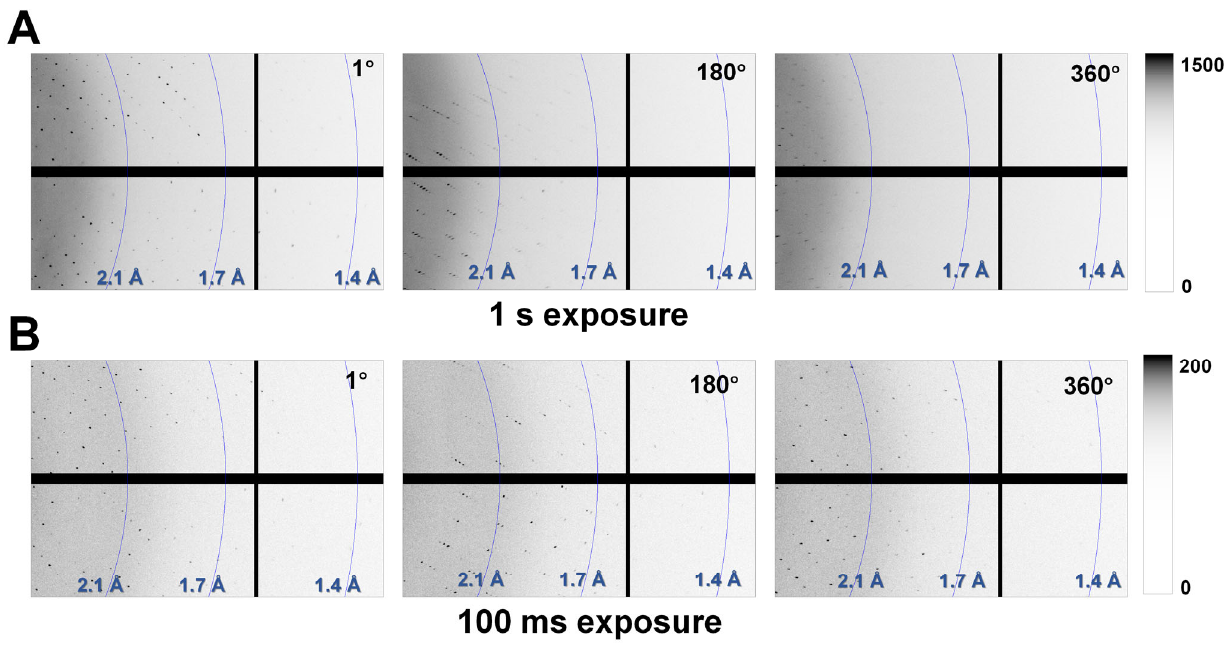
Figure 2. Magnified views of the diffraction patterns of ( A ) Thaumatin 1s and ( B ) Thaumatin 100ms recorded at oscillation angles of 1°, 180°, and 360°.